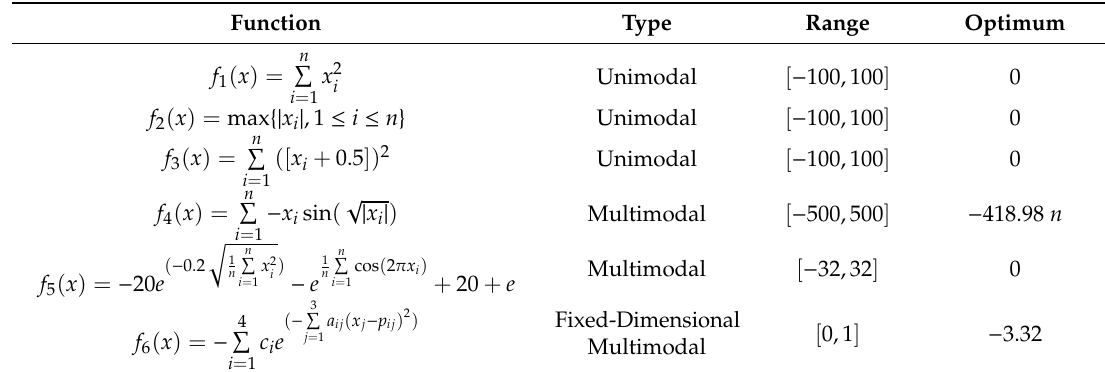
Table 1. Benchmark functions of the algorithm performance test.